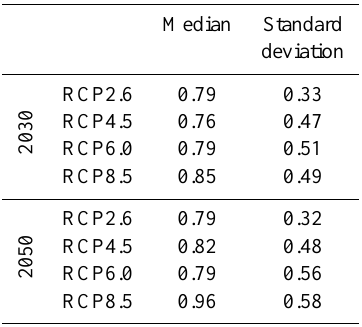
Table 4. Median and standard deviation of precipitation multiplica- tion factor between the five GCMs for each RCP scenario in 2030 and 2050.